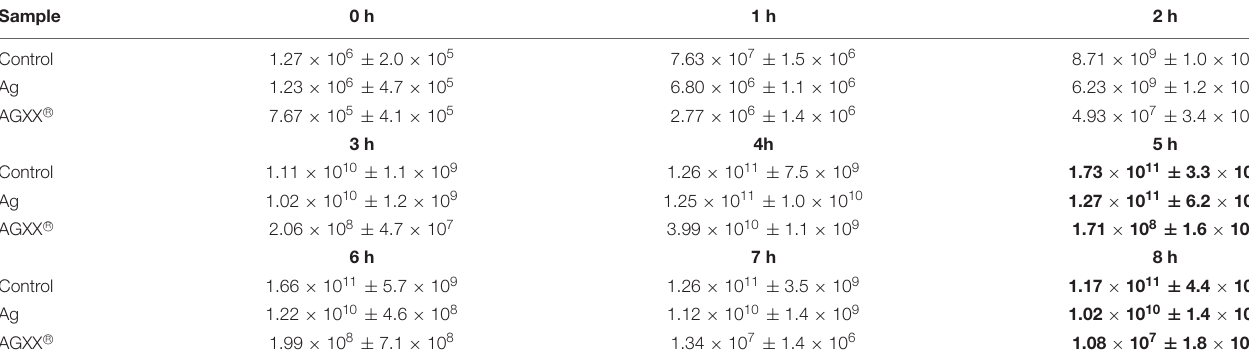
The values for 5th hour and 8th hour are bolded because after t = 5h, the CFU values of MRSA + Ag decreased. And until t = 8h, the CFU values for all the three samples (MRSA, MRSA + Ag, and MRSA + AGXX) decreased.